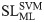
The accuracy of all estimation methods versus the number of time points Tobs.The left panel shows the mean squared error, while the right panel shows the median absolute error. The three colors represent the three parameters. Blue lines refer to the parameter r, red lines to the parameter σ and yellow lines to the parameter ϕ. The solid line represents the original synthetic likelihood approach SLOrig (stopping at Tobs = 103), the dashed line the SLMLSVM prepaid approach and the dotted line the SLMLSVM prepaid approach.